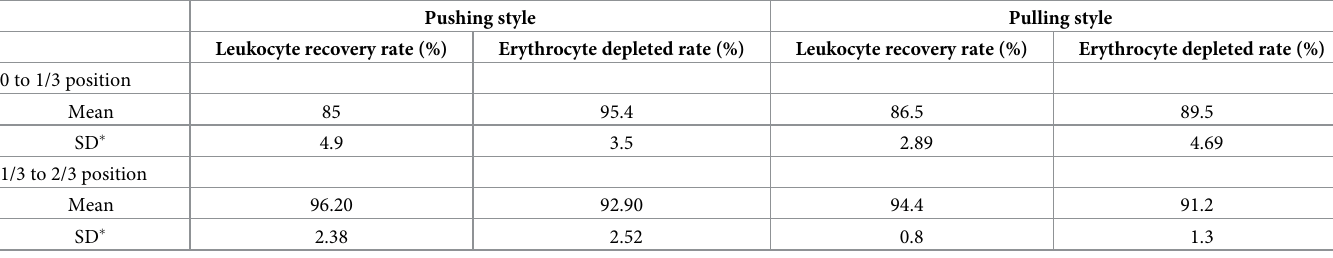
Table 1. Optimizing the methodological parameters of leukocyte enrichment by